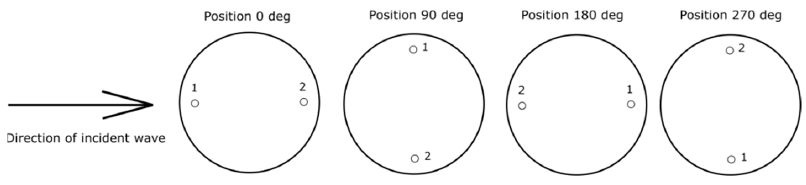
Figure 4. Positioning of the head with reference to the sound source.